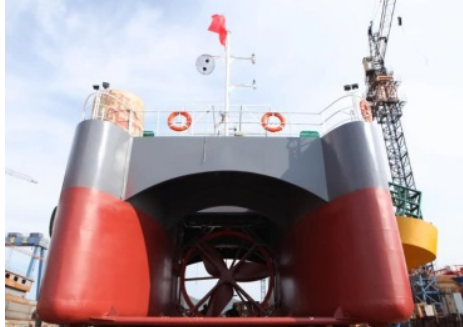
Figure 9. Marine experimental platform.